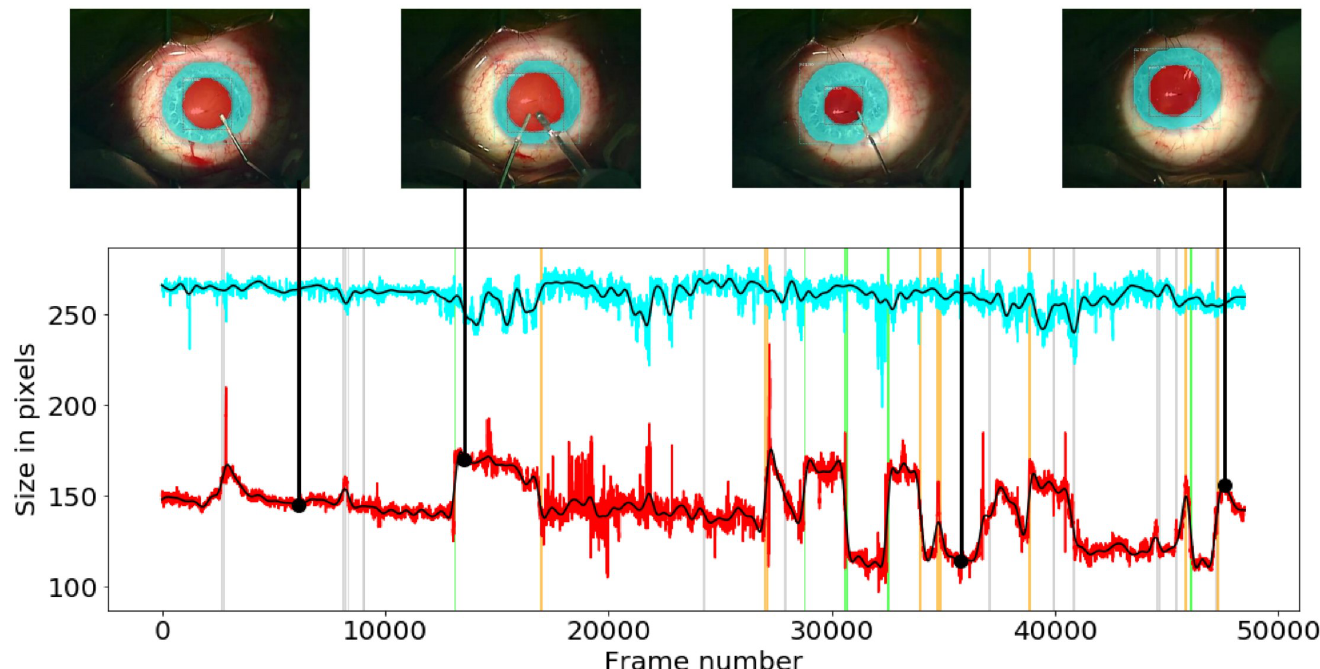
Fig 6. Example of the original limbus (cyan) and pupil (red) width values. Both signals are filtered with the Butterworth filter and a cutoff frequency of 0.1 Hz (black) in one video with strong (green), medium (orange), and weak (gray) annotations. The pictures over the graph are the automatically segmented frames at corresponding